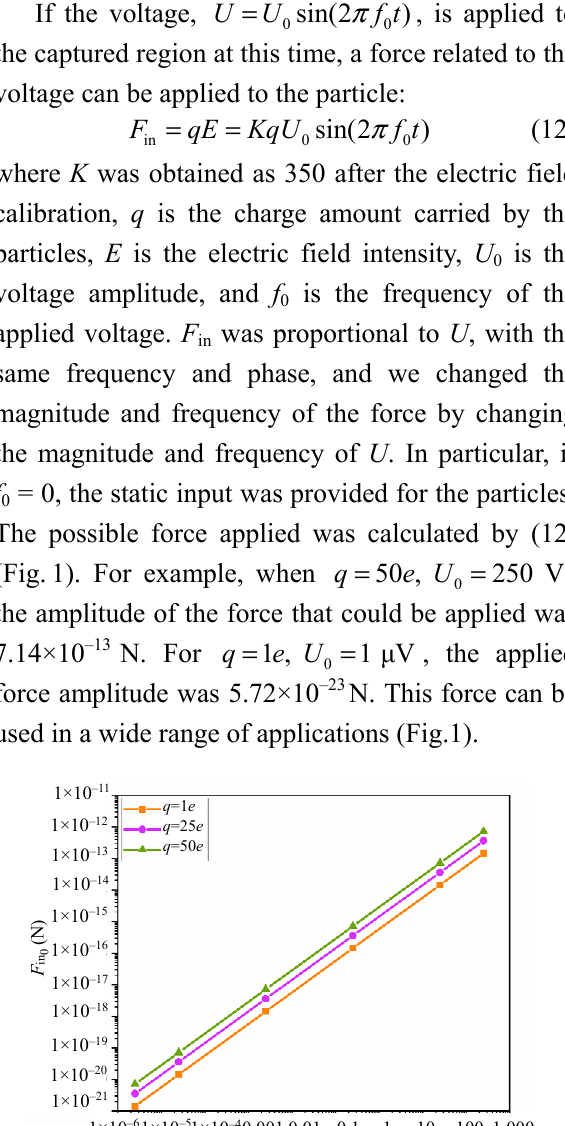
Fig. 1 Relationship between coordinate